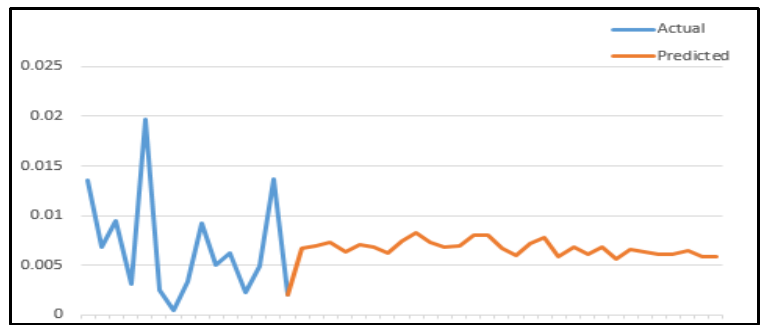
Figure.7. Long-term (60 days) prediction from NNAR